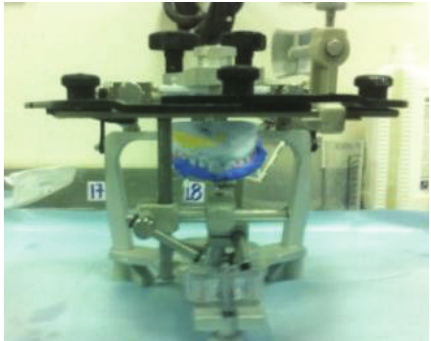
Figure 4: Face bow mounted on articulator.